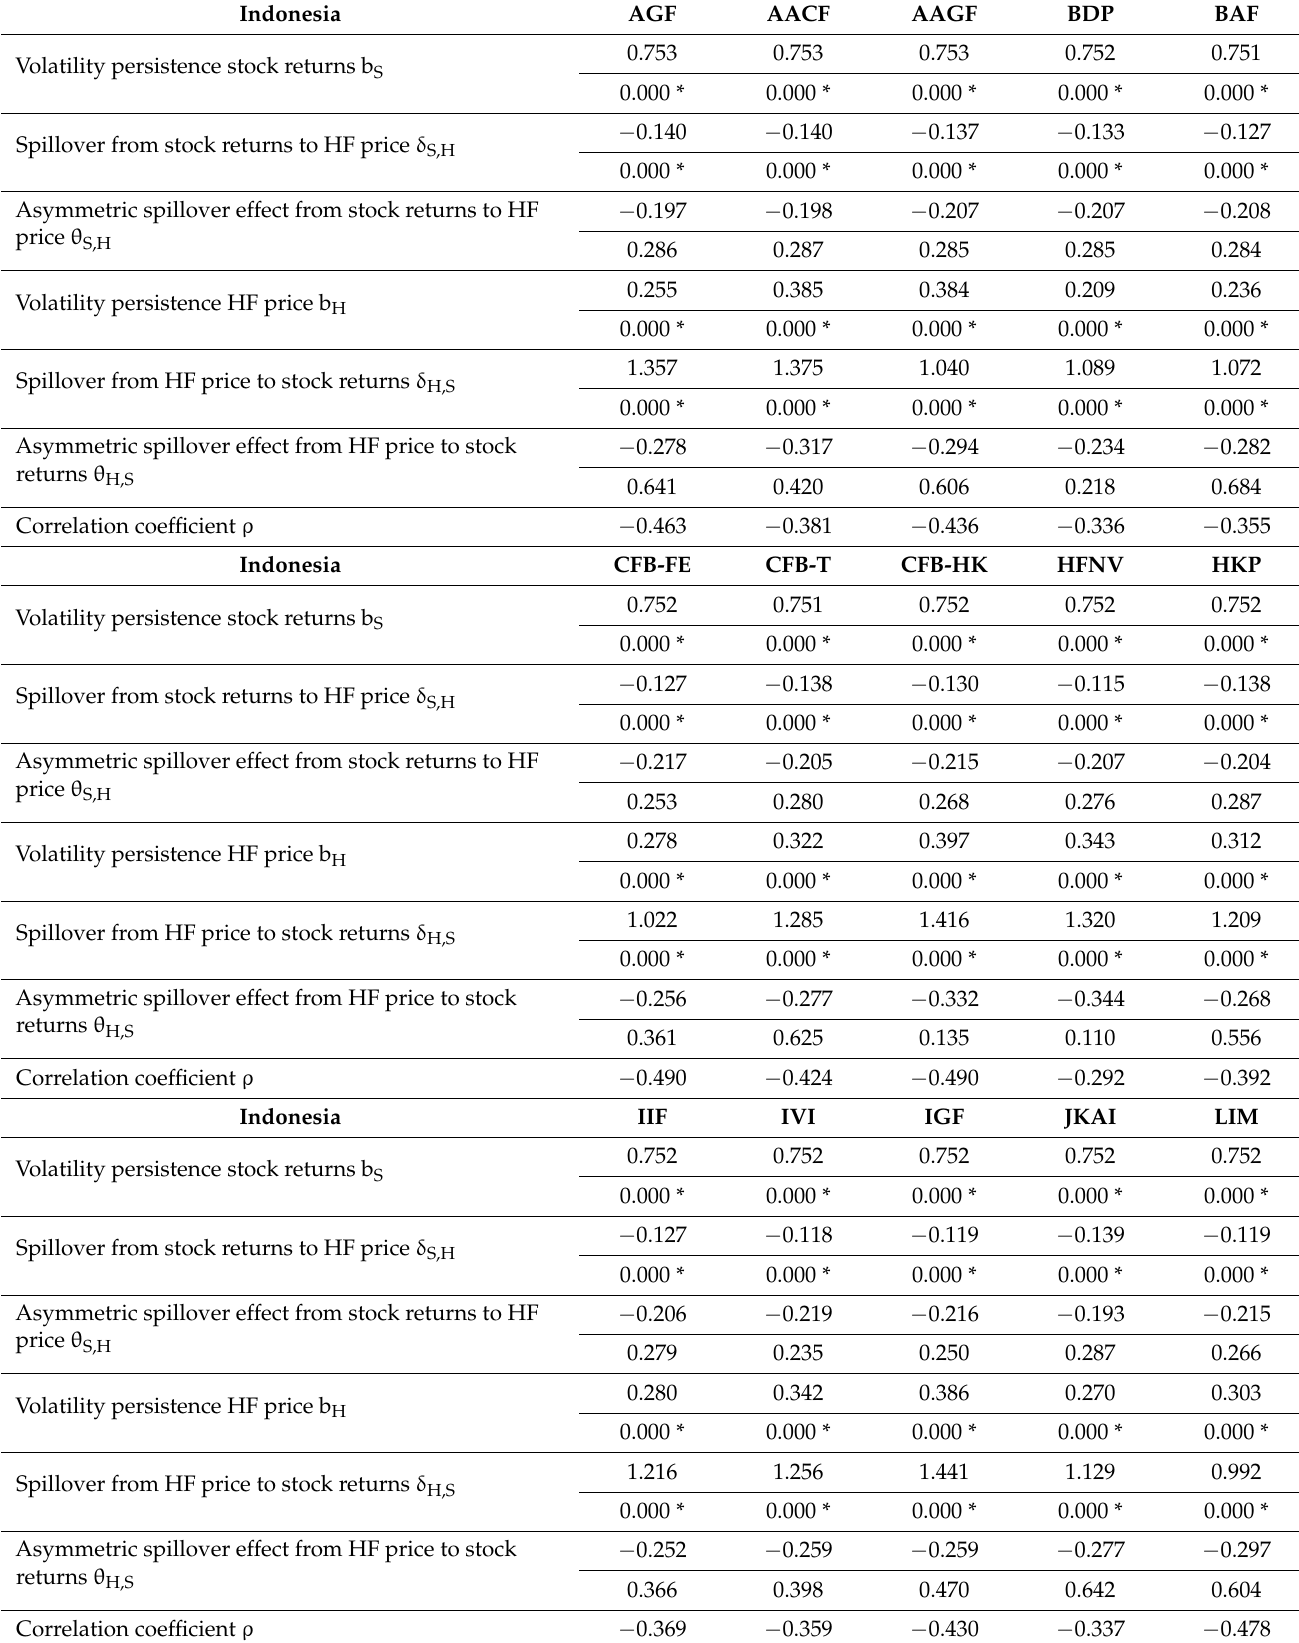
Table 11. Volatility spillover between the Indonesian Stock Market (JCI) and Hedge Fund